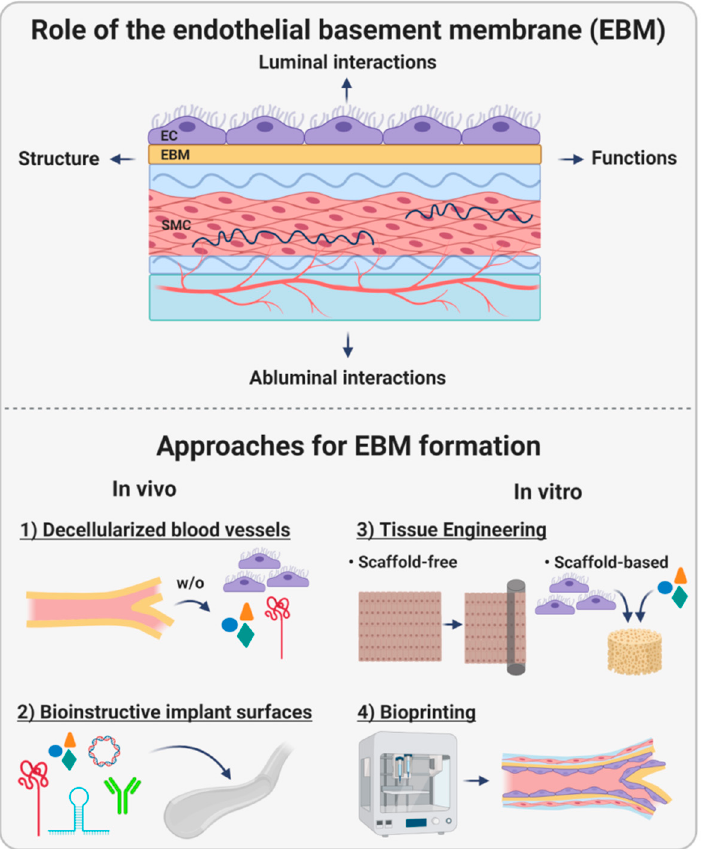
Figure 1. The endothelial basement membrane (EBM). This review describes the role of the EBM, including its structure and functions, especially its luminal and abluminal interactions with adjacent cells. Moreover, multiple design strategies for cardiovascular implants aiming to imitate the EBM or stimulate its formation are described, including decellularization of natural blood vessels, implant biofunctionalization, tissue engineering, and bioprinting.